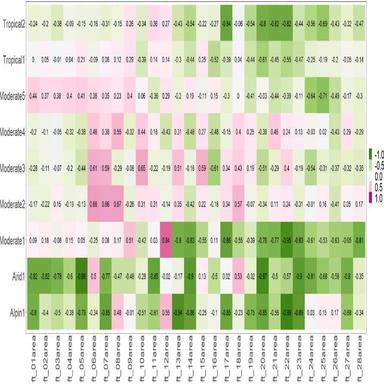
Correlation matrix of the extracted IR bands and pmpp (calculated for data after initial power increase, i.e., data measured after >500 h of exposure); green indicates an increase in the band area with decreasing pmpp, pink indicates a decrease in band area with decreasing pmpp.